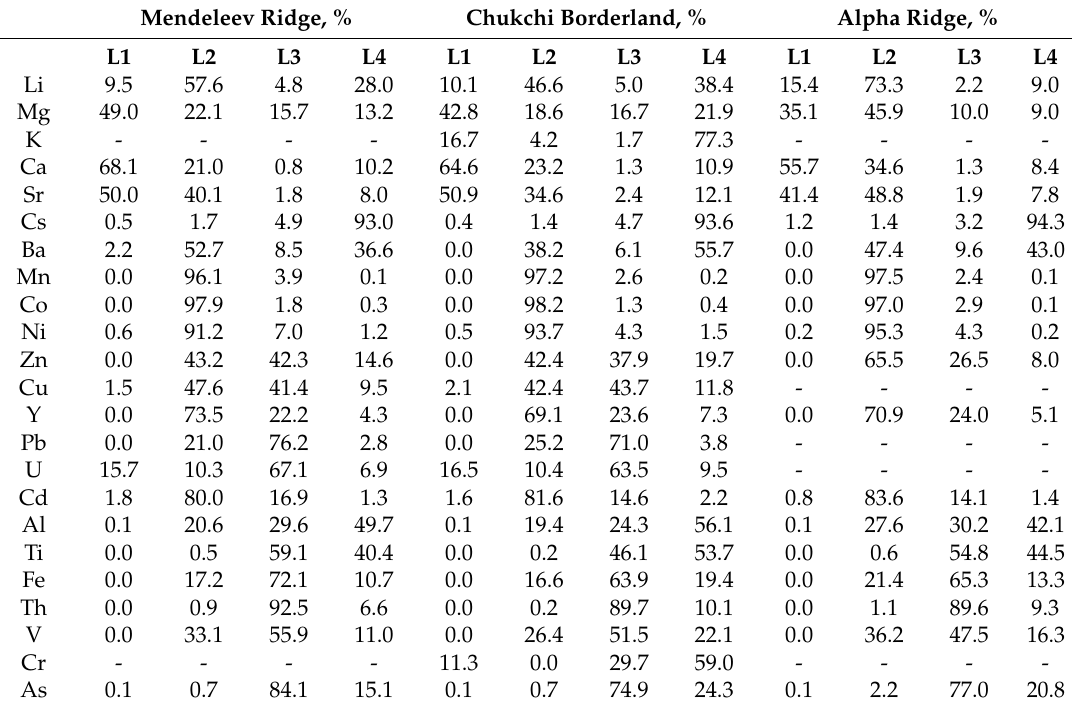
Table 7. Mean percentage distribution of elements in four leaches of Arctic hydrogenetic crusts. Mendeleev Ridge, % Chukchi Borderland, % Alpha Ridge,